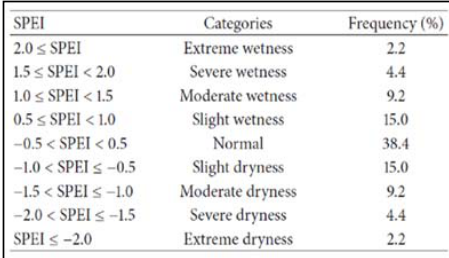
Figure 2. Classification of the Standardized Precipitation Evapotranspiration Index (SPEI).